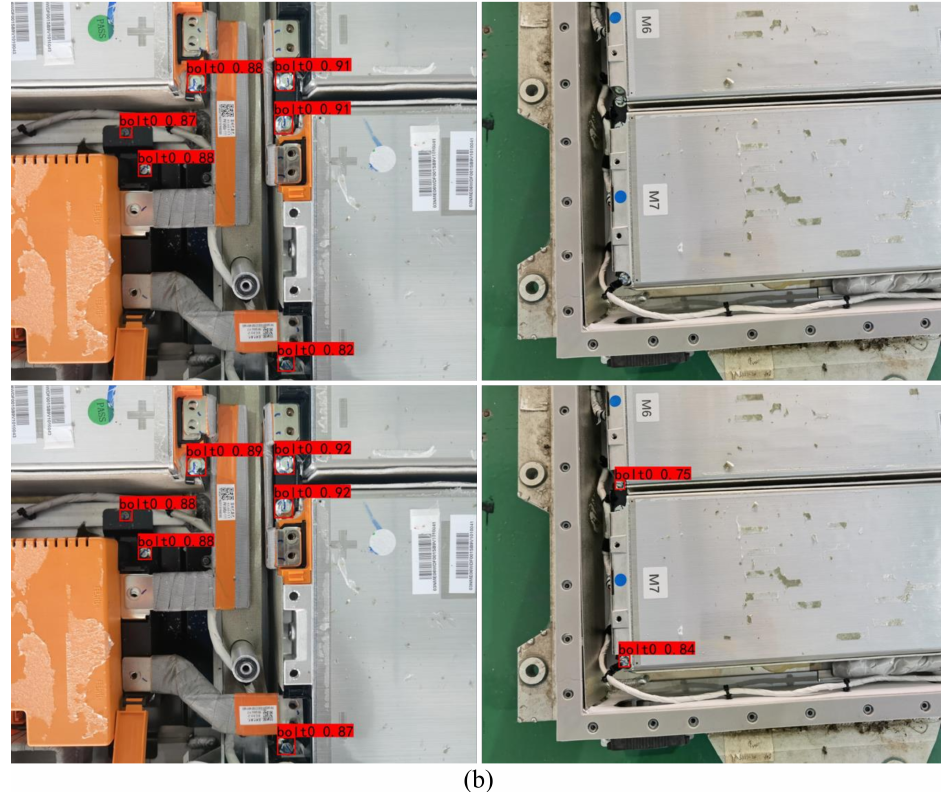
Figure 20. Effect of the original YOLOX ( a ) and the improved YOLOX ( b ) on screw detection